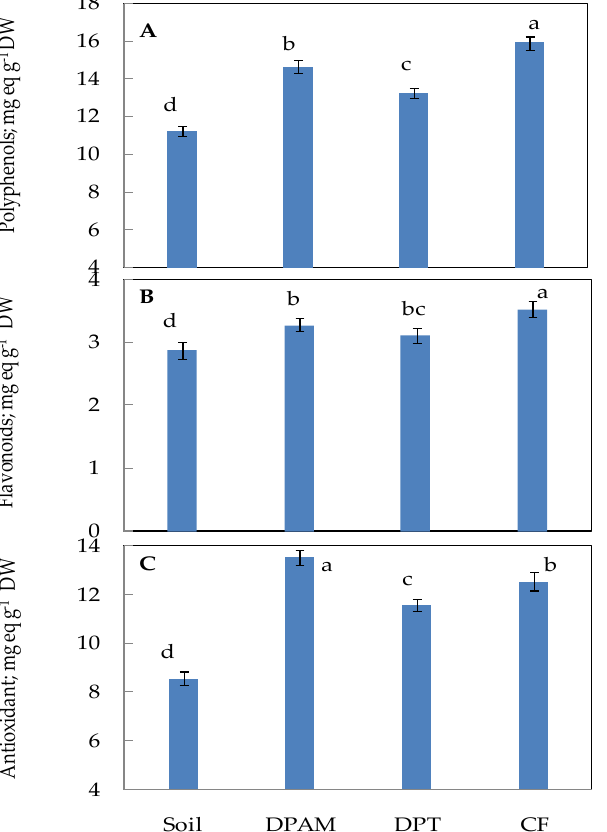
Figure 4. Phytochemical composition and antioxidant activity of extract of tomato fruit grown on different substrates. DPAM: compost of date-palm residues and animal manure; DPT: compost of date-palm trunk; CF: coconut fiber, compared with soil substrate. ( A ): Total polyphenols content; ( B ): total flavonoid content; ( C ): antioxidant activities. Results are expressed as gallic acid or catechin equivalents (mg equivalent g − 1 DW) and represent the mean of triplicate determinations ± S.D. Vertical bars indicate standard errors of means. Numbers followed by a different letter within a panel are significantly different at p ≤ 0.05, according to LSD